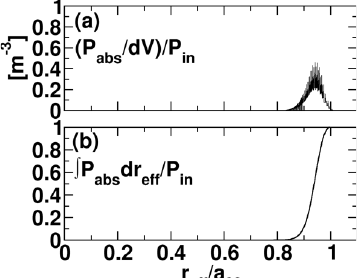
Fig.6 : (a) modulation amplitude normalized by the time average, (b) coherence function, and (c) phase delay are plotted versus the normalized minor radius for the 23 Hz component obtained by FFT analysis of each ECE channel from 6.0 s. to 7.0 s.